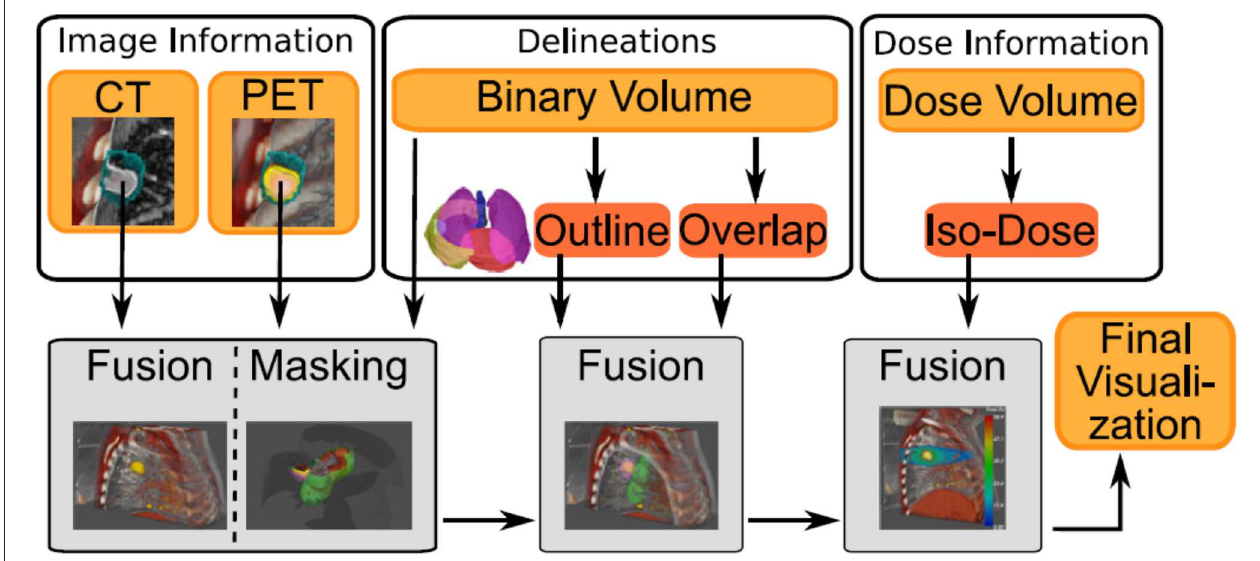
FIGURE 6 | Example of image sources (volume rendering or segmentation) from different modalities, where each type of modalities will be processed differently to provide the final visualization. Figure extracted from Schlachter et al. [ 104] under the Creative Commons Attribution